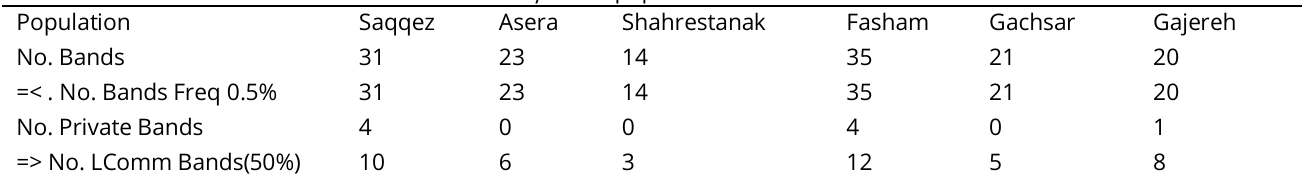
Table 4. Details of ISSR bands obtained in L. peltata populations studied.